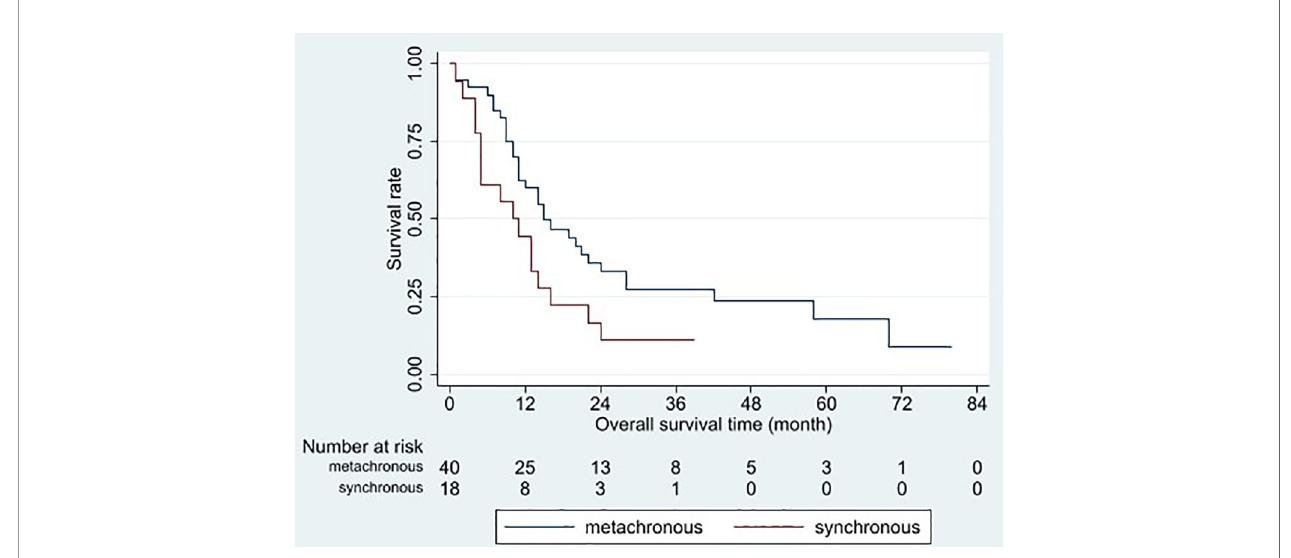
FIGURE 5 | Overall survival curves for different timings of liver metastasis occurrences. Patients with metachronous metastasis had better overall survival than those with synchronous metastasis (p = 0.046).